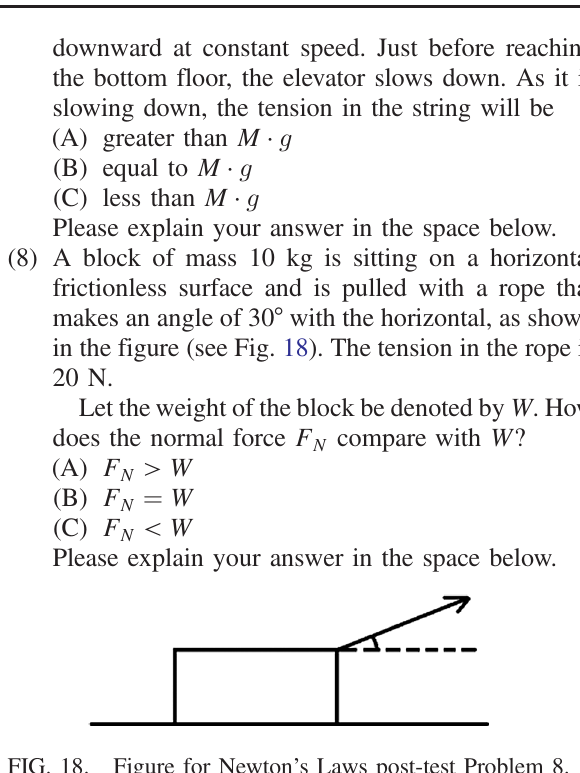
FIG. 18. Figure for Newton ’ s Laws post-test Problem 8.